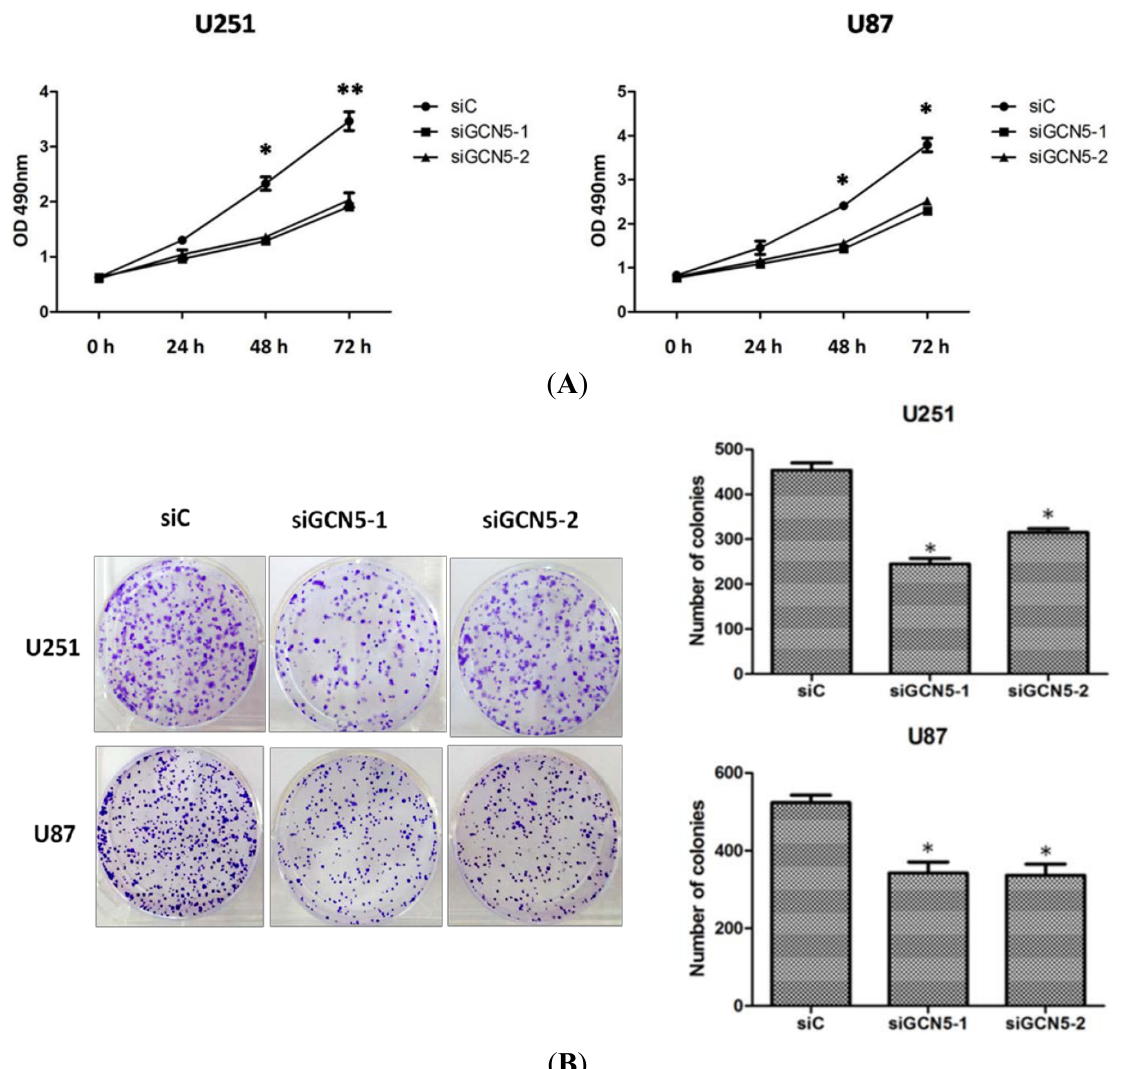
Figure 4. GCN5 knockdown suppressed cell proliferation and colony formation ability. ( A ) MTS assay indicated that GCN5 knockdown suppressed cell growth rate in U251 and U87 cell lines; ( B ) Colony formation assay showed that GCN5 knockdown suppressed cell colony formation ability in U251 and U87 cell lines (* p < 0.05; ** p <